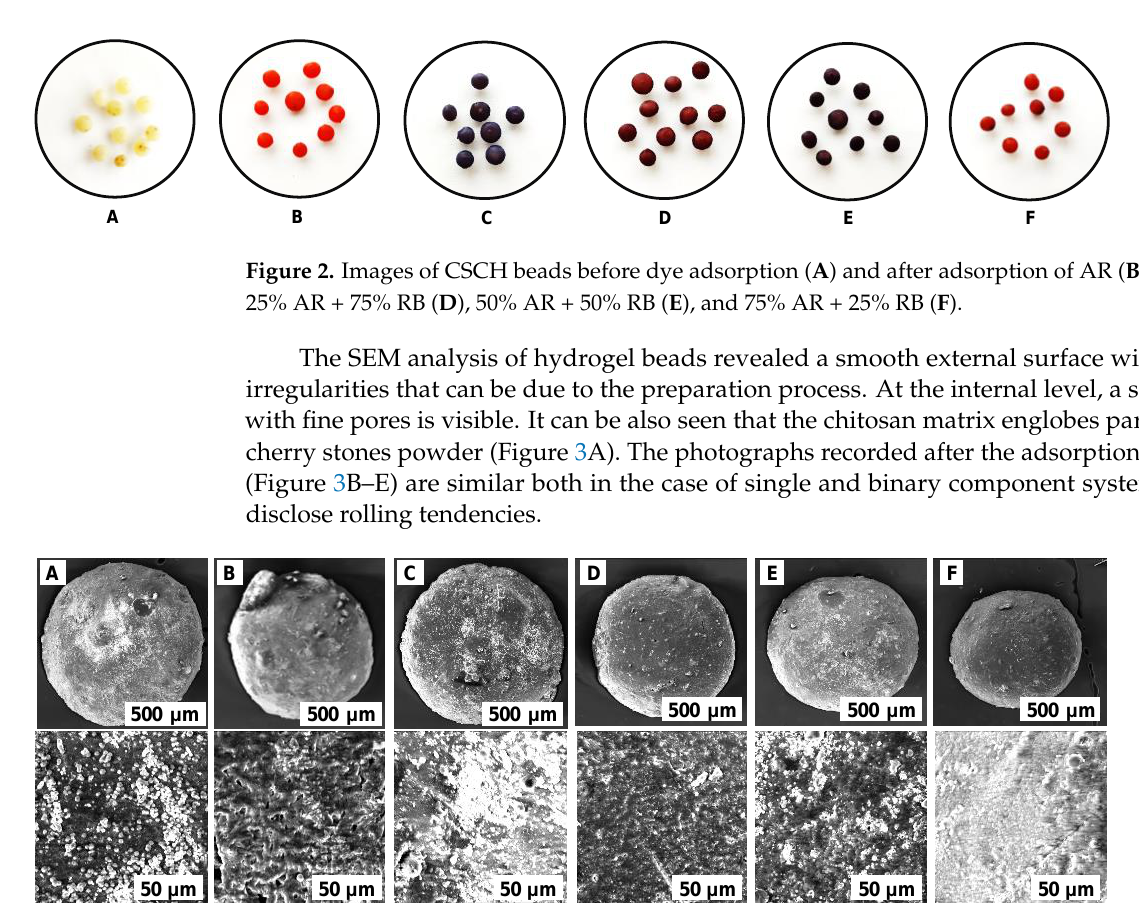
4 of 23 Figure 1. Hydrogel beads preparation procedure.